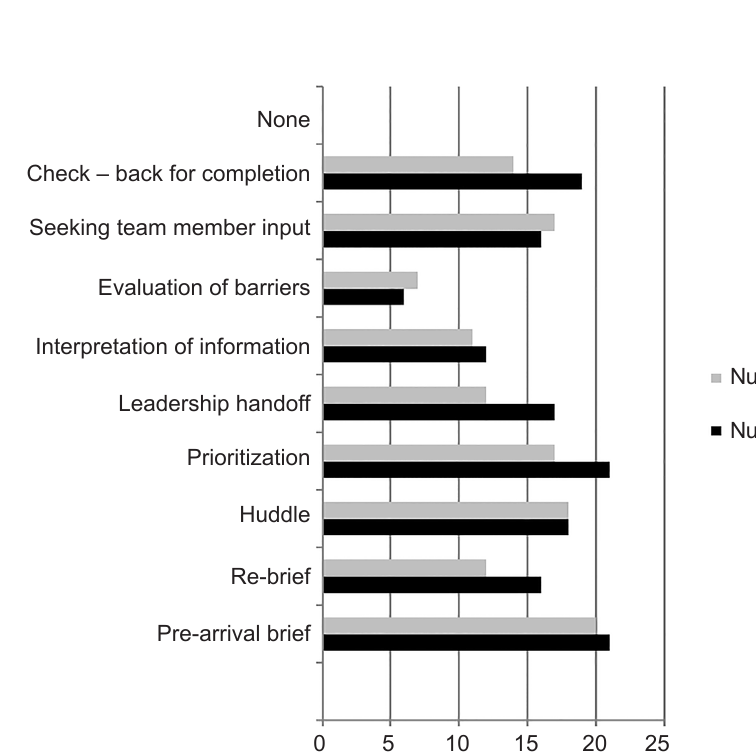
IQR , interquartile